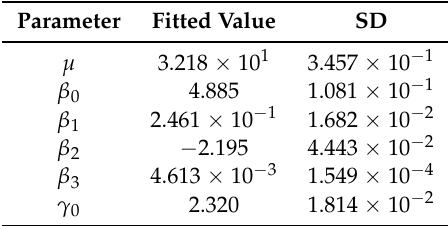
Table 4. Estimated parameters for model